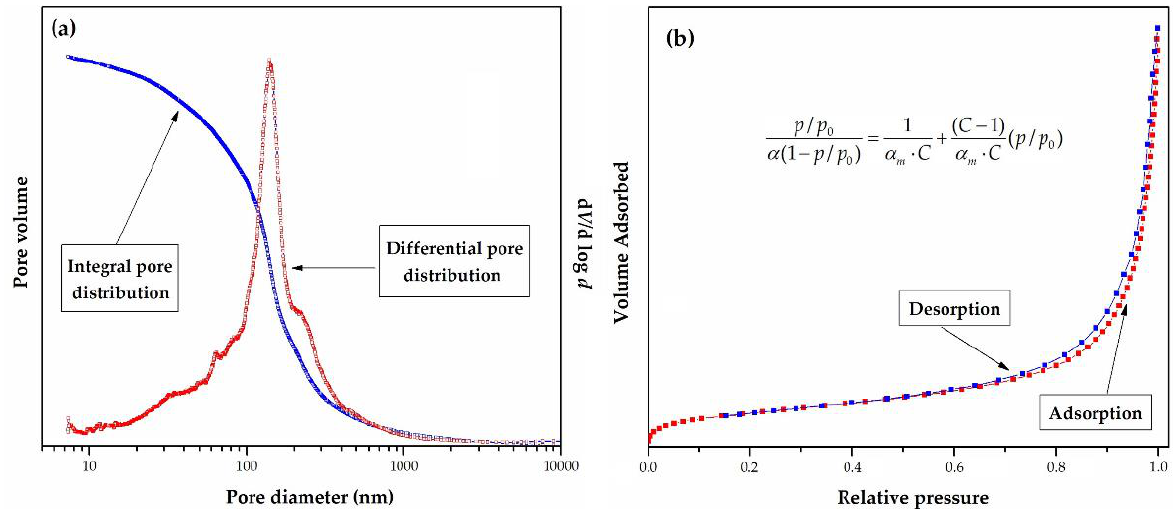
Figure 6. ( a ) Integral (cumulative) and differential pore size distribution curves and ( b ) adsorption/desorption isotherm measured at 77 K for sample PGME-deta.